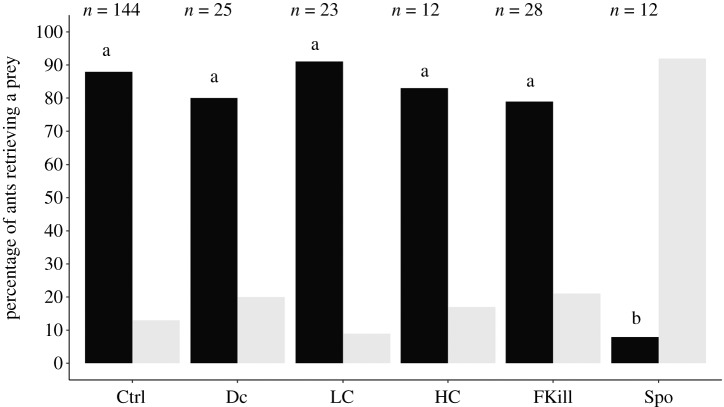
Percentage of ants retrieving a prey item (black bars) or not (grey bars) among workers that contacted a single fly depending on its level of fungal infection. For the Ctrl prey, we pooled all the retrieval events observed across the experimental conditions that used a cold-killed control prey (n = 144). n value above bar is the total number of ants that contacted the corresponding prey. Post hoc multiple pairwise comparisons were made with Bonferroni correction. Bars sharing a common letter were not significantly different.